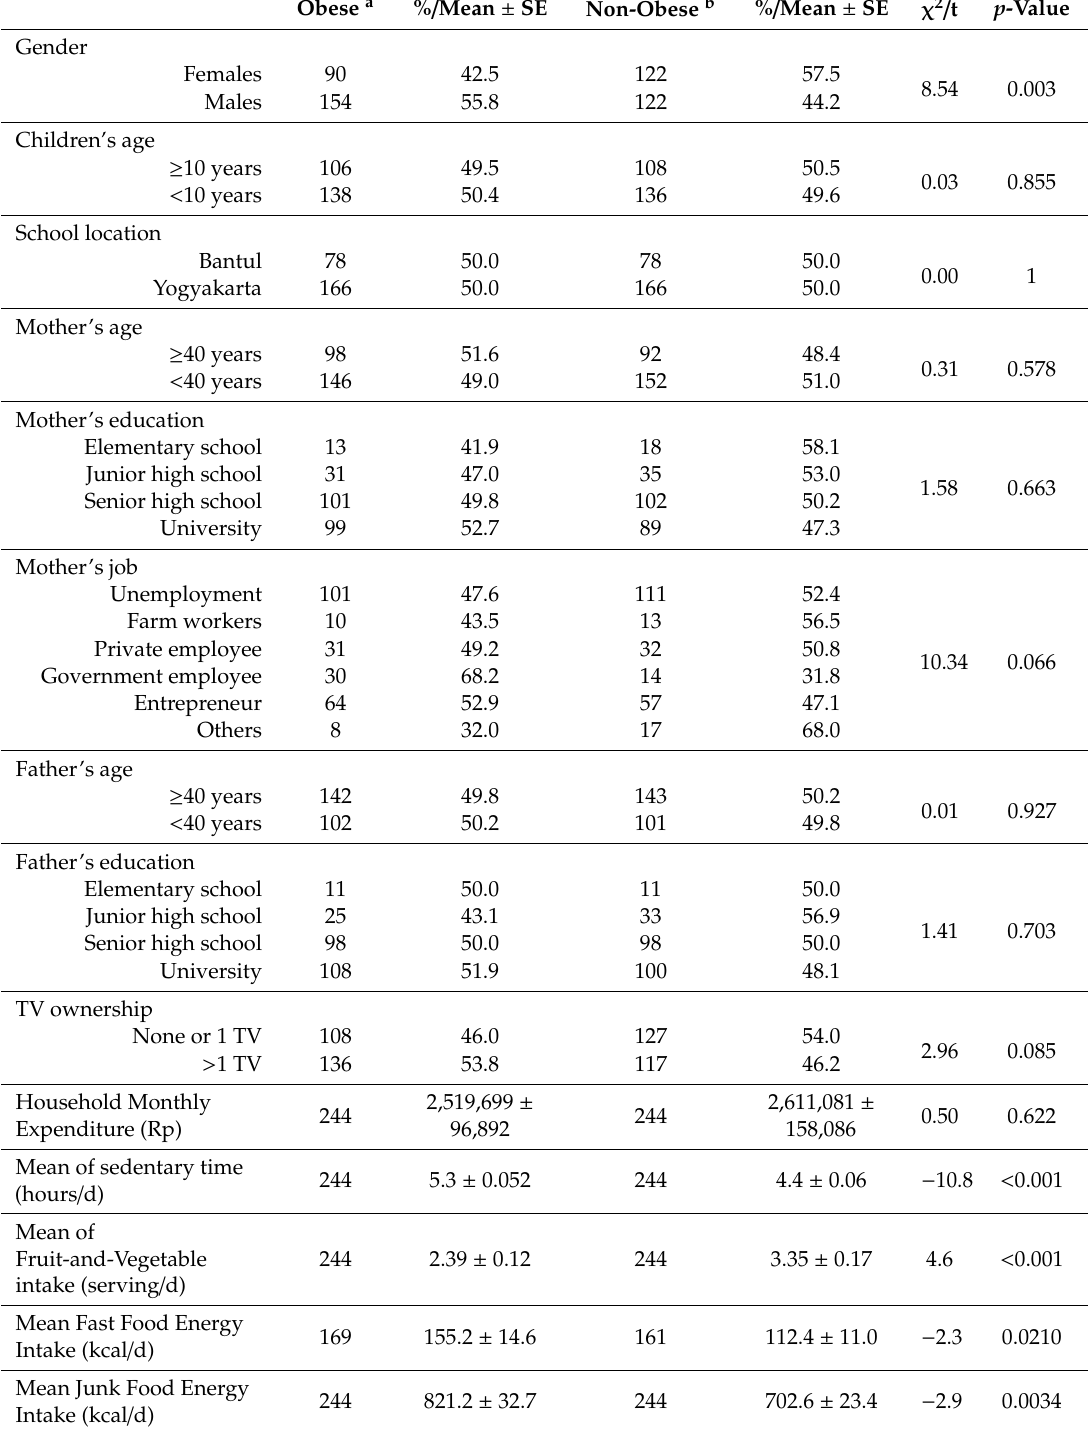
Table 1. Characteristics of obese cases ( n = 244) and non-obese controls ( n = 244) 7–12 years of age, Yogyakarta,